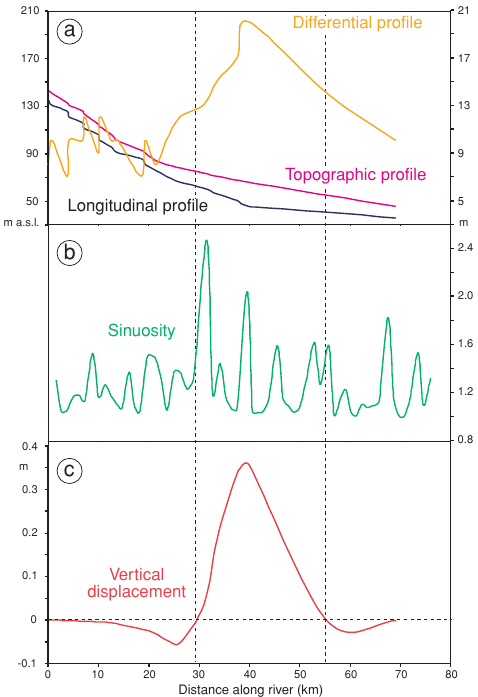
Fig. 6a-c. Profiles of the Oglio River from the Alpine frontal moraines to the confluence with the Mella River. a) The differential profile, obtained by subtracting the elevation of the river bed from the average elevation of the Plain main level, shows a dramatic increase of inci- sion in the distance range 30-50 km, suggesting that the river meets an area of localised uplift. b) An increment of sinuosity highlighted at about 30 km from the upper-end of the section is possibly related to a variation of the lon- gitudinal slope of the river bed. c) Expected vertical dis- placement along the river bed generated by slip on a blind, 30°-north dipping thrust fault (full faulting param- eters and location of the modelled fault shown in fig. 8 and table II). This fault explains the geomorphic obser- vations (longitudinal anomalies of the Oglio River as well as its SE-diversion) and fits subsurface geological data (see upper-left inset of fig. 7). We suggest that this fault is the causative source of the 1802